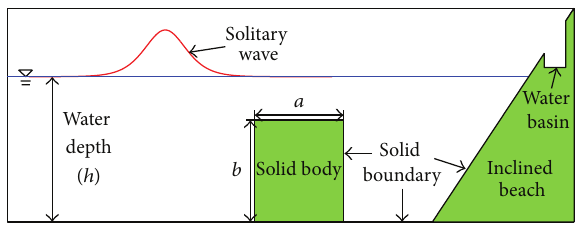
Figure 5: Illustration of a numerical wave